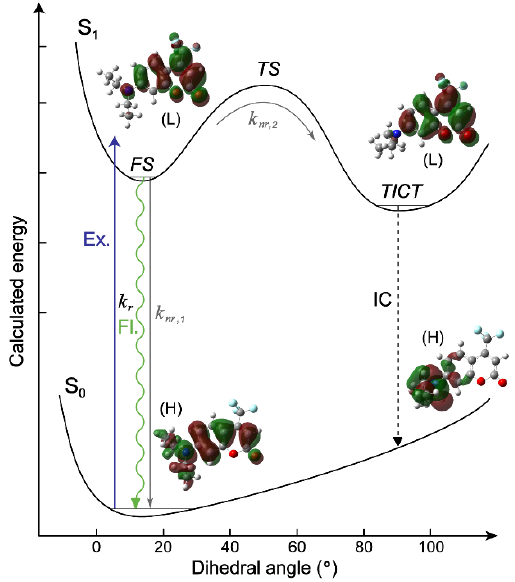
Figure 3. Schematic of potential energy surfaces of C481 in solution as a function of the diethylamino group twisting angle. The calculated frontier molecular orbitals in S 0 (HOMO, H) and S 1 (LUMO, L) for C481 with electronic density maps are shown in FS and TICT states, through a transition state (TS). Radiative ( k r ) and nonradiative ( k nr = k nr ,1 + k nr ,2 ) rate constants are denoted by their associated processes. Ex., excitation (blue solid arrow upward); Fl., fluorescence (green wavy line downward); IC, internal conversion (black dashed line downward, a nonradiative transition).